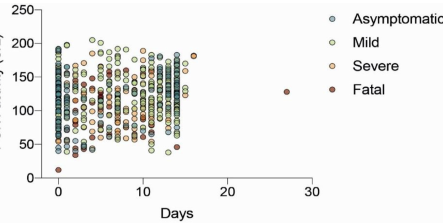
Figure 3. Serum paraoxonase-1 (PON1) activities in COVID-19 patients segregated according to the severity of symptoms and the days post-onset of the infection.